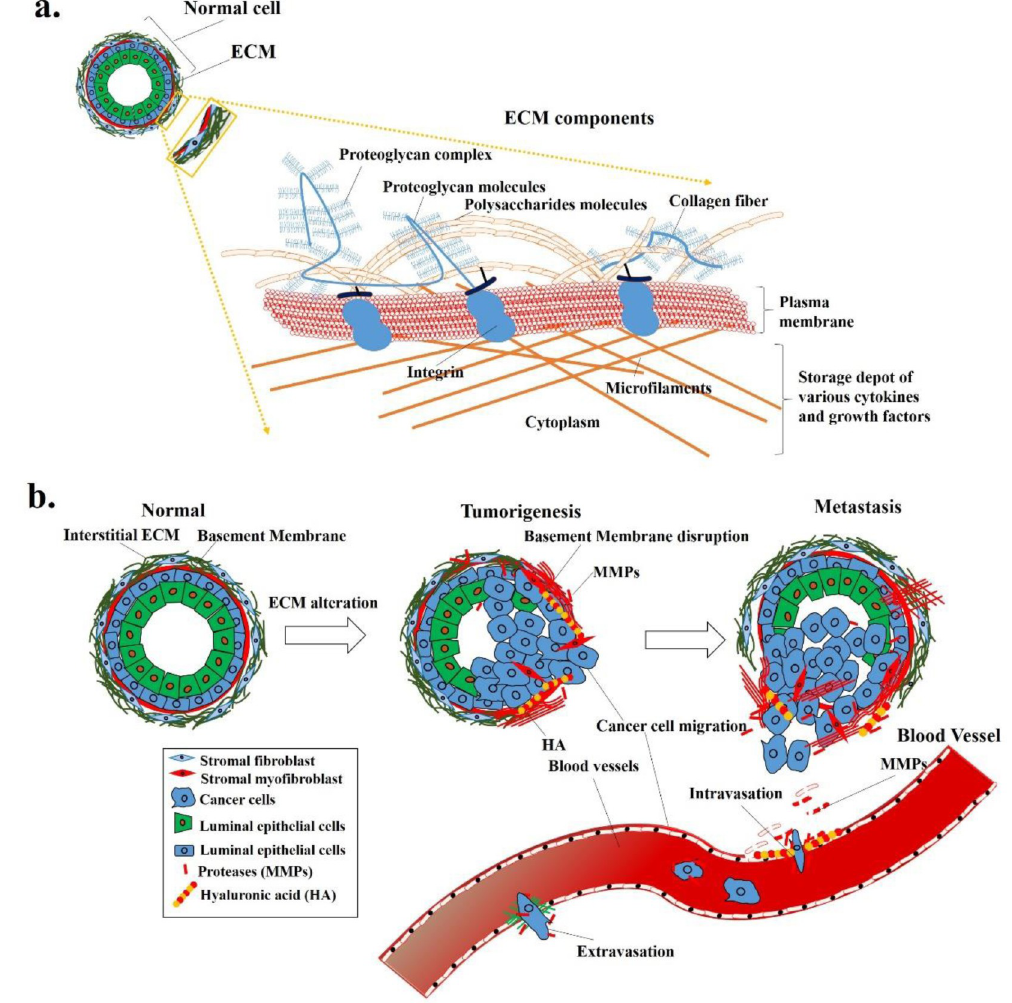
Fig 1. Extracellular matrix (ECM) components and their alterations during tumor development and progression. (a) ECM components, including proteoglycans, collagens, integrins, and many other substances, form a network structure, and (b) alterations of ECM networks may allow tumor cells to migrate from the original site to distant organs and develop into